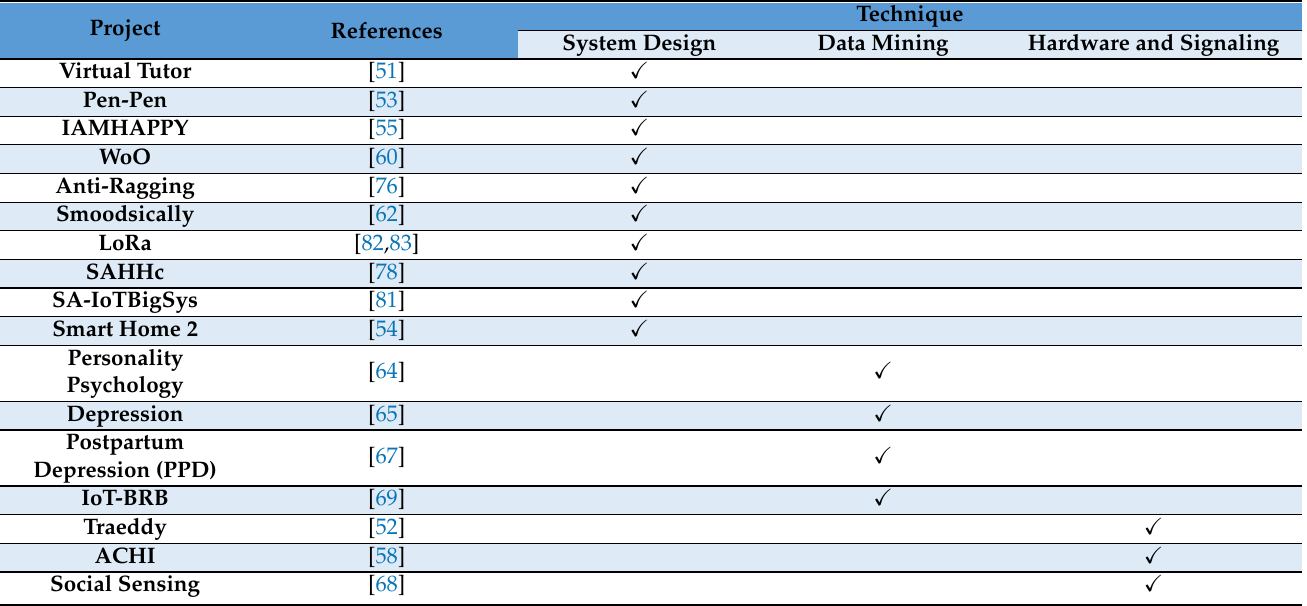
Table 2. Summary of IoT-based psychological projects from the perspective of